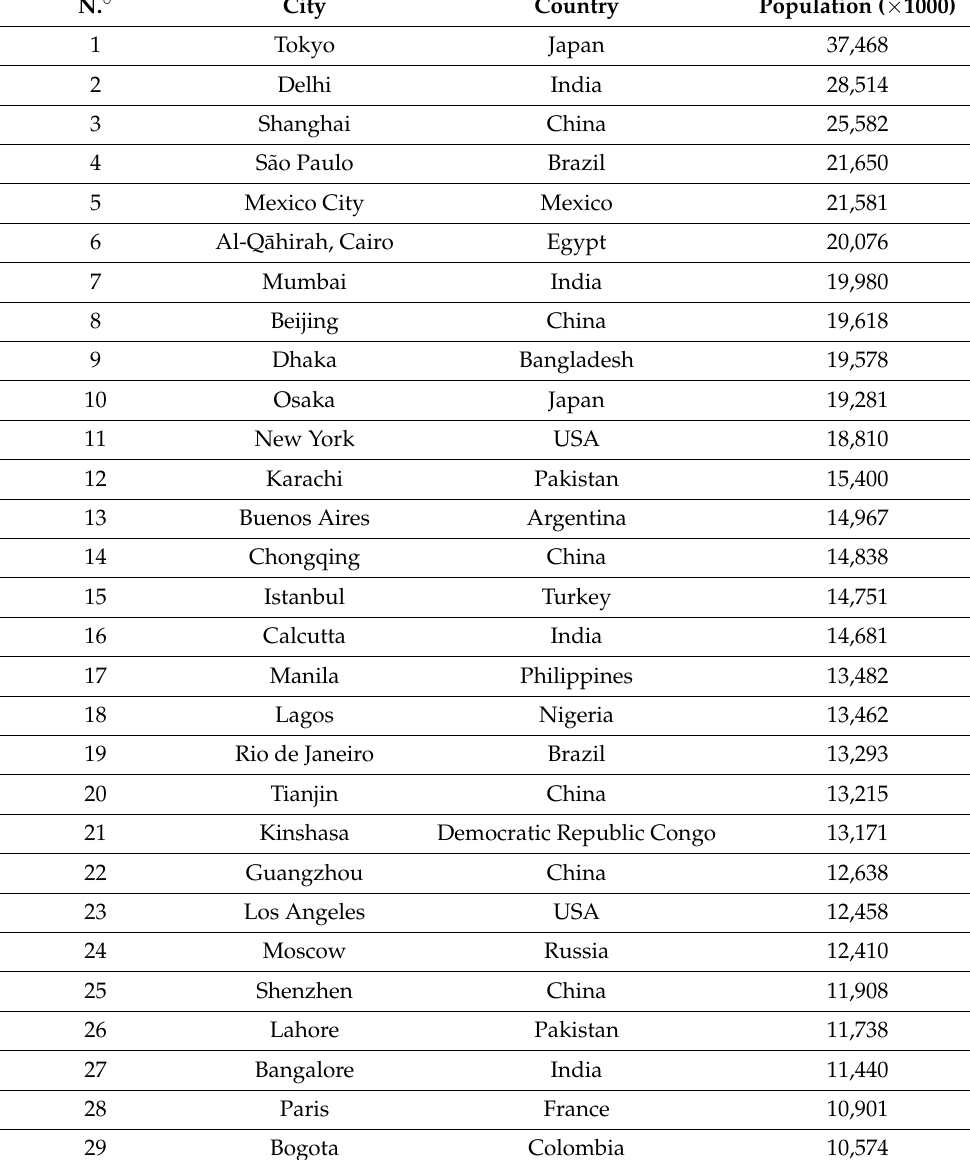
Table 1. World cities and their populations